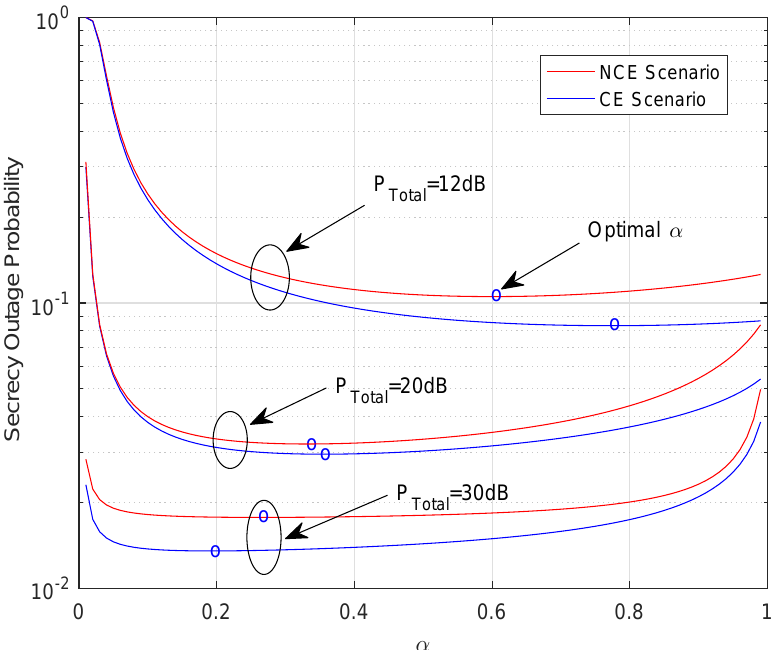
Figure 7. Secrecy outage probability vs. the power allocation factor α for the SCJ-OPA scheme under the NCE and CE scenarios when R s = 0.5 (bit/s/Hz), M = L = 2, K = 2, and P Total = 12, 20, 30